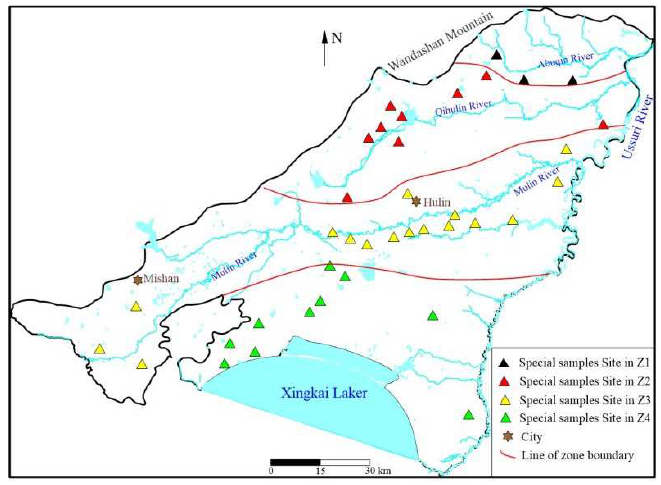
Figure 9. The distribution of the special samples in four zones.